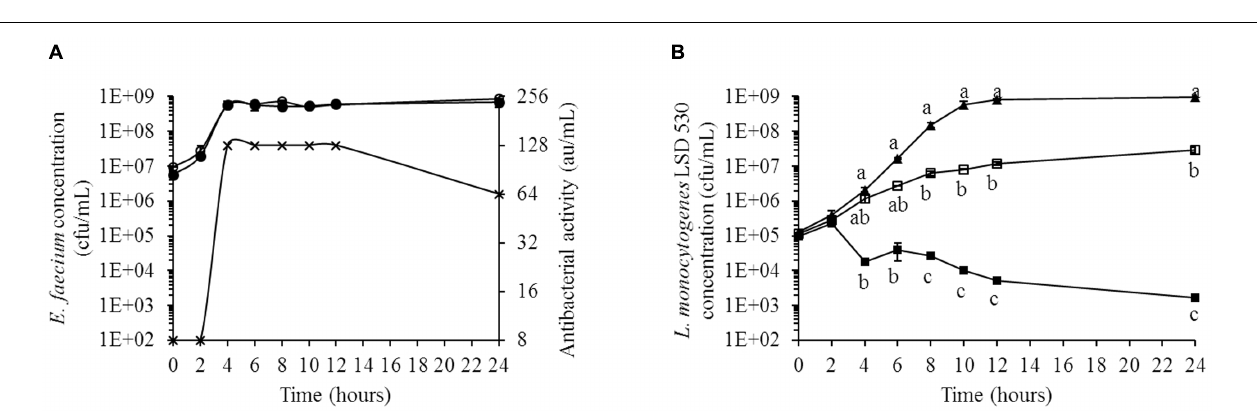
FIGURE 5 | Adhesion of L. monocytogenes LSD 529 to Caco-2 cells (A) and HT-29 cells (B) alone and in competition with E. faecium LCW 44, LCW 44d or L. rhamnosus GG. Adherent bacteria titer was measured by plating on agar after 1 h of contact. Error bars indicate the standard error of the mean. Different letters indicate significant difference between assays (Tukey’s HSD test, P < 0.05, n = 3).